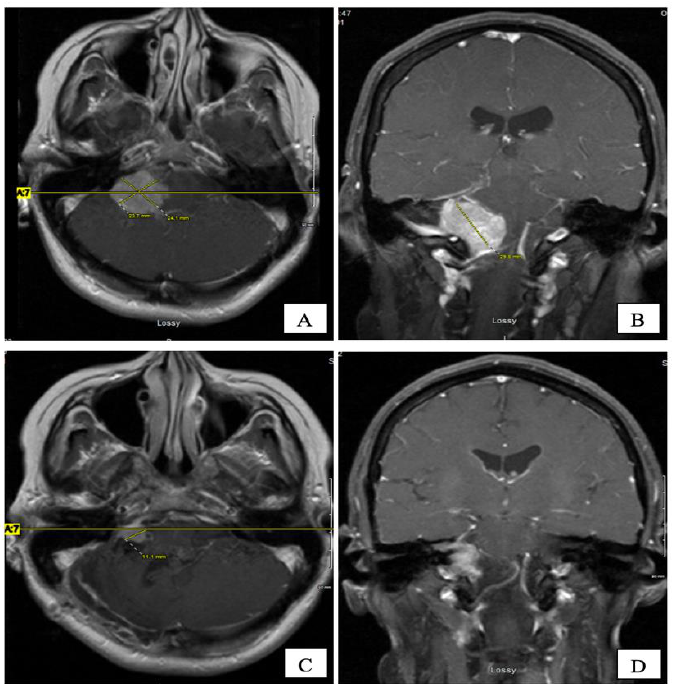
Figure 2. Pre-operative (( A ) axial, and ( B ) coronal) and 2 months post-operative (( C ) axial, and ( D ) coronal) post-gadolinium T1-W MRI sequences. The CPA tumour measured 24 × 24 × 30 mm and 11 × 9 mm, respectively.